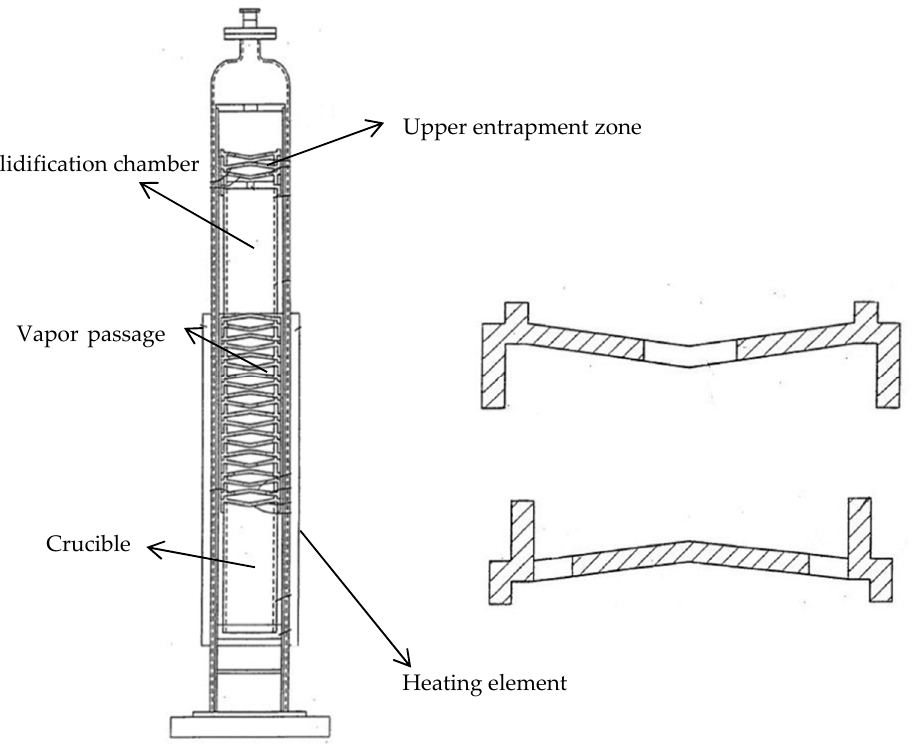
Figure 6. Vacuum distillation column as devised by Tayama and Kimura ( left ) and vapor passage plates ( right ).